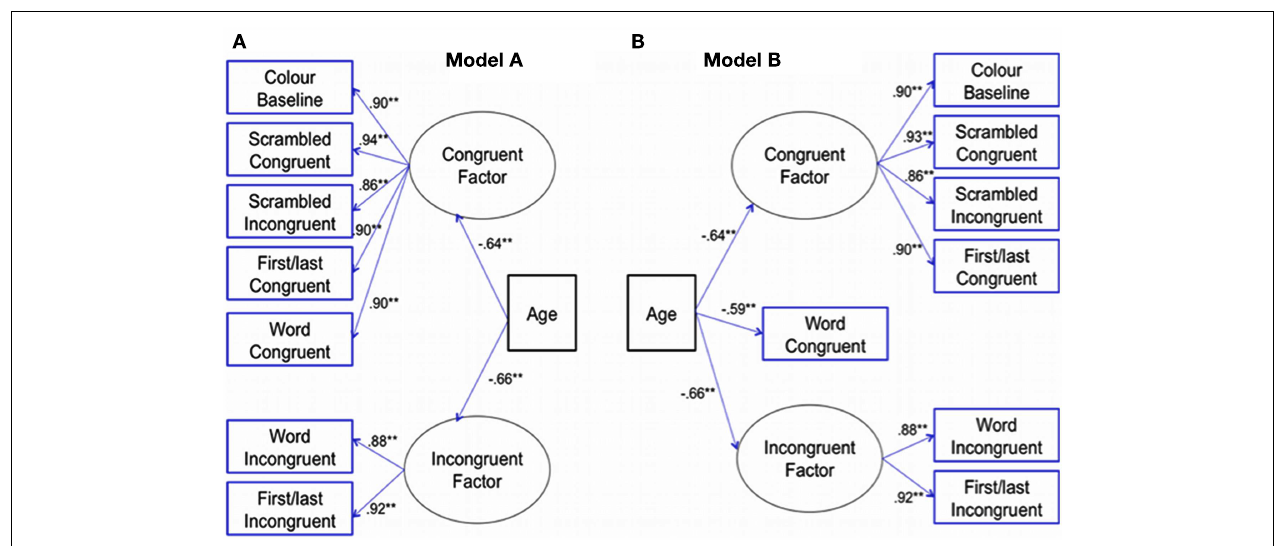
onto a latent congruent factor. (B) Depicts a path with a better fit showing theWord-congruent significantly loading on its own; rest were same as Model